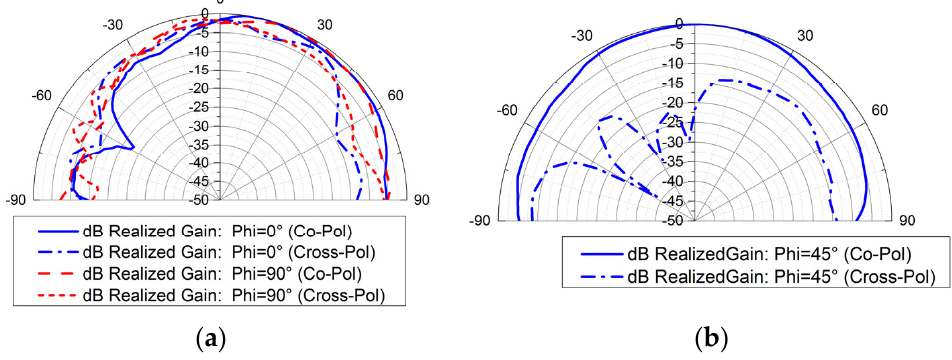
Figure 16. Measured results. ( a ) In the OFF state, in a circular polarization; ( b ) in the ON state, in a linear polarization. linear